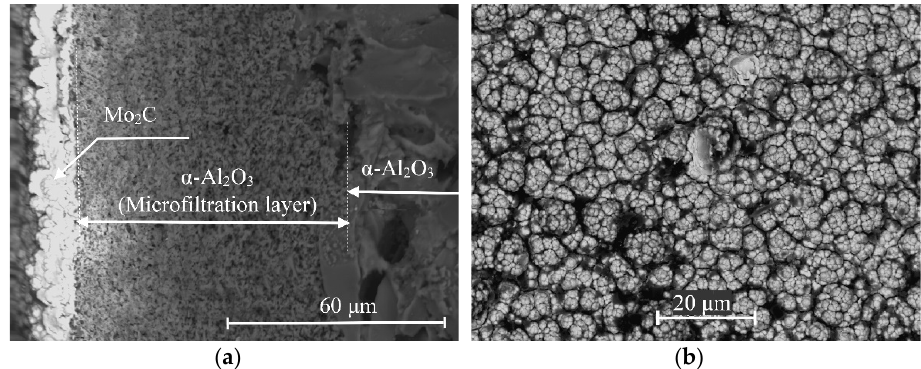
Figure 3. SEM images of the cross-section ( a ) and the outer surface ( b ) of the membrane catalyst.